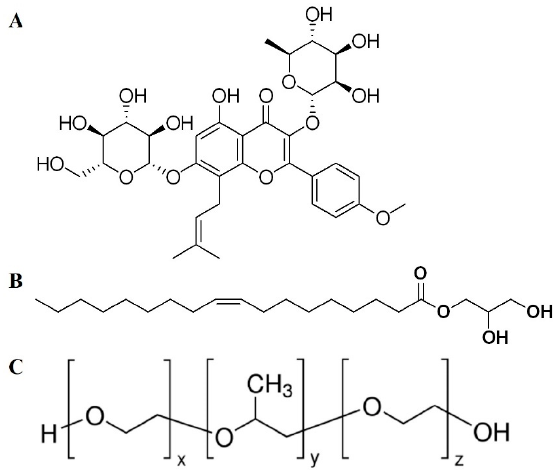
Figure 1. Chemical structure of ( A ) icariin (ICA), ( B ) glyceryl monooleate (GMO), and ( C ) poloxamer 407 (P407).